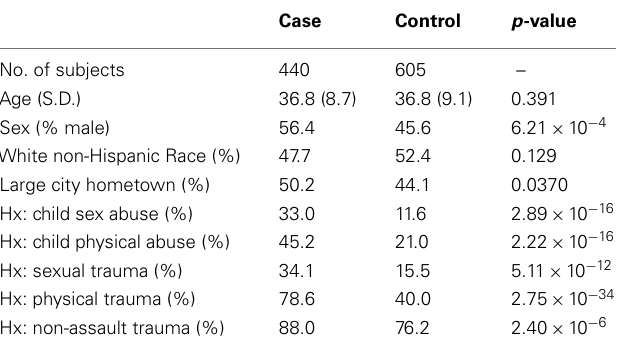
Table 1 | Distribution of FSCD-assessed personal characteristics and facets of environment, and the estimated p -value for cocaine dependence associations in this study.